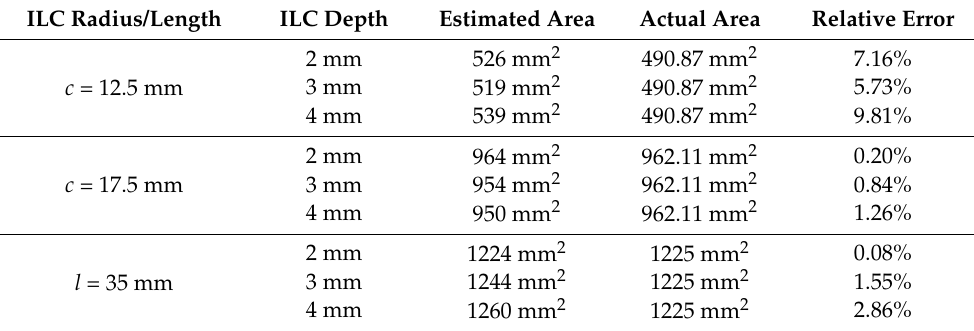
Table 4. Assessment results regarding ILC opening areas for ILC Scenario